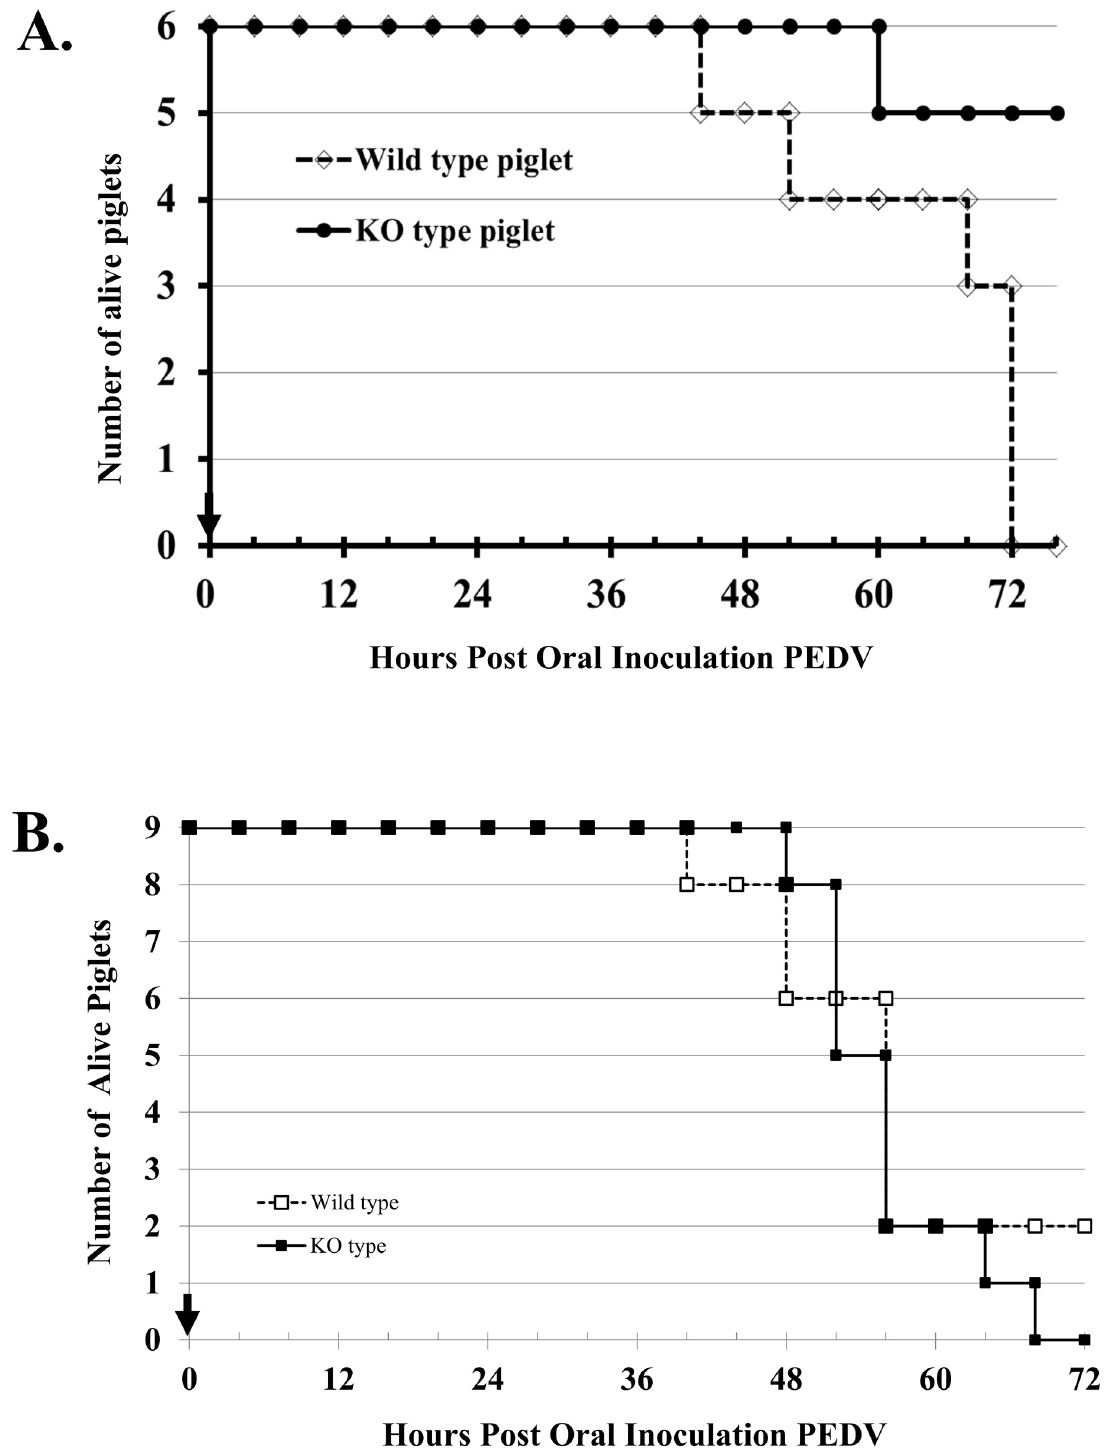
Fig 6. Survival of neonatal piglets after oral inoculation with nv-PEDV. A (Exp. I), 2-day-old piglets’; and B (Exp. II), 3-day-old neonatal piglets’ survival curve after inoculated with nv-PEDV. Solid circles (A) or squares (B) with lines represent the CMAH KO piglets, and open diamonds (A) or squares (B) with dashed lines indicate wild-type piglets. The arrow shows the time of inoculation. In A at 72 hpi, three moribund WT piglets are classified as dead piglets.